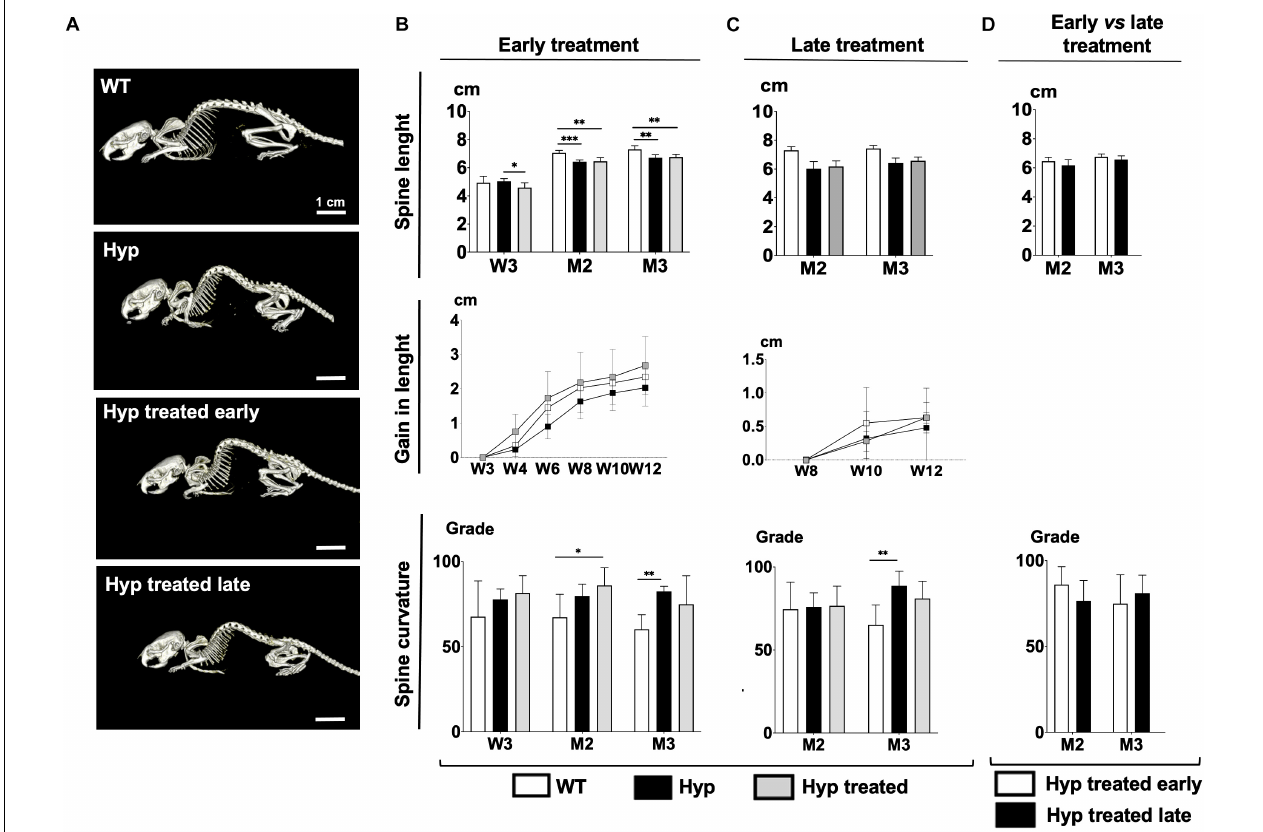
FIGURE 1 | (A) Total body images of WT mice, untreated Hyp mice, and Hyp mice on conventional treatment started early at M3. (B) Spine length, gain in length, and spine curvature at baseline (W3), M2 and M3 evaluated with micro-CT in WT mice, untreated Hyp mice, and Hyp mice on conventional treatment started early. (C) Spine length, gain in length, and spine curvature at baseline (M2) and M3 evaluated with micro-CT in WT mice, untreated Hyp mice, and Hyp mice on conventional treatment started late. (D) Spine length and curvature of Hyp mice on conventional treatment started early compared to Hyp mice on conventional treatment started late. W3, 4, 6, 8, 10, 12: 3, 4, 6, 8, 10, 12 weeks; M2: 2 months; M3: 3 months; * p < 0.05; ** p < 0.01; *** p < 0.001.